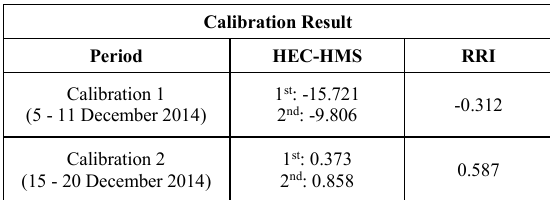
Table 4. Result comparison between HEC-HMS and RRI